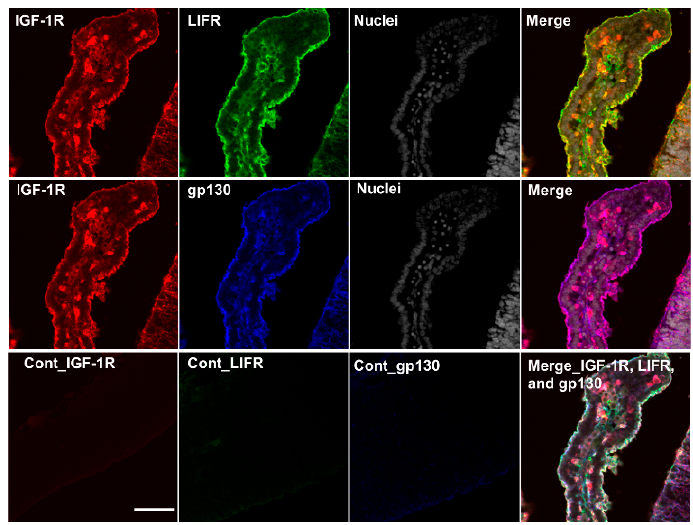
Figure 7. Localization of IGF-1R, LIFR, and gp130 in the choroid plexus of the lateral ventricle at E15.5. Localization of IGF1-R (red), LIFR (green), and gp130 (blue) was observed in the apical side of the choroid plexus epithelium. The co-localization of all three receptors is shown in white. The nuclei were stained with Hoechst 33,342 (gray). Cont: negative controls stained with non-immunized rabbit IgG, respectively. Scale bar: 25 µm.